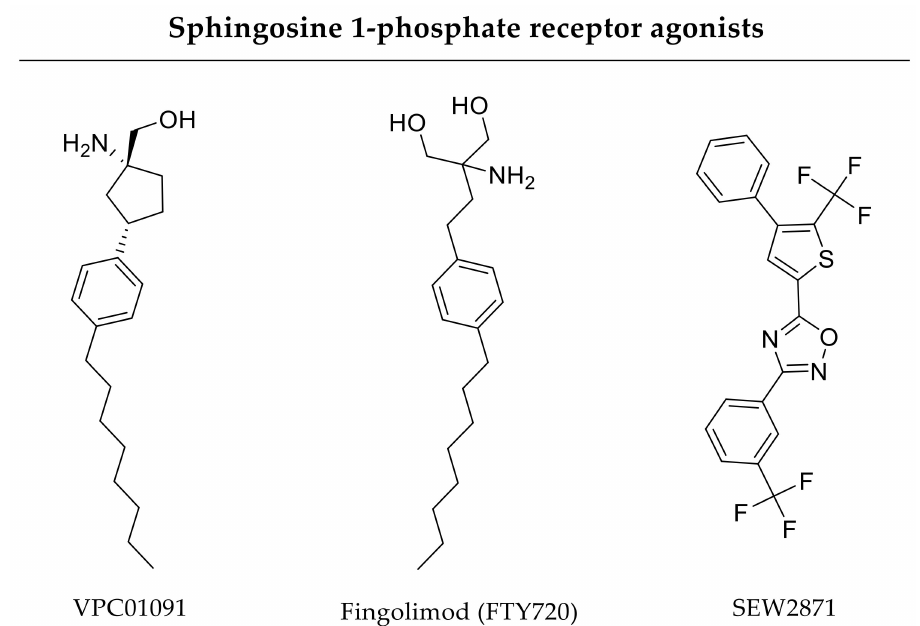
Figure 5. Chemical structures of sphingosine 1-phosphate receptor agonists. The lipid mediators act mainly on vascularization and bone metabolic